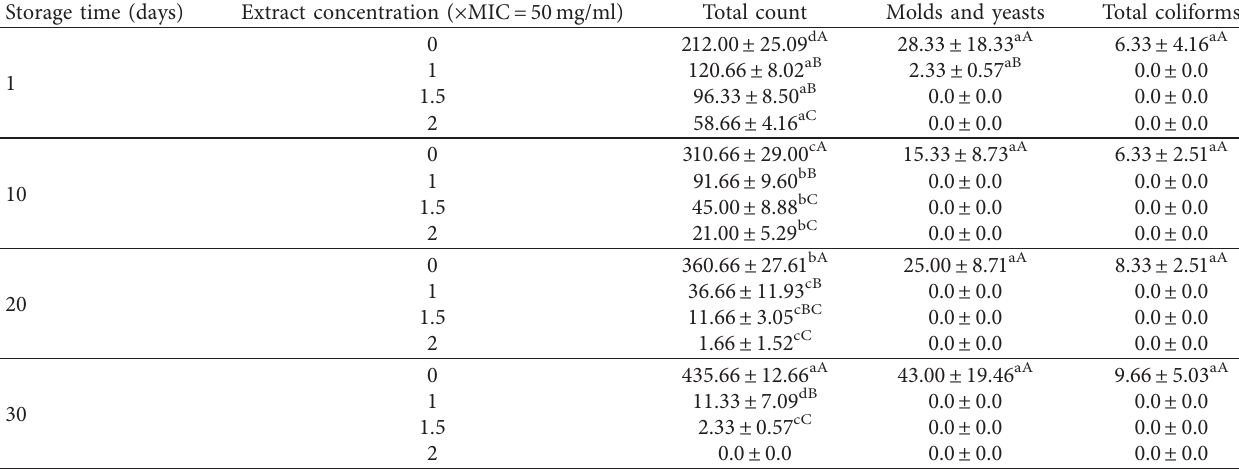
Table 3: Antibacterial effects of different concentrations of pomegranate peel ethanolic extract incorporated in coatings of emergency food product during 30 days of